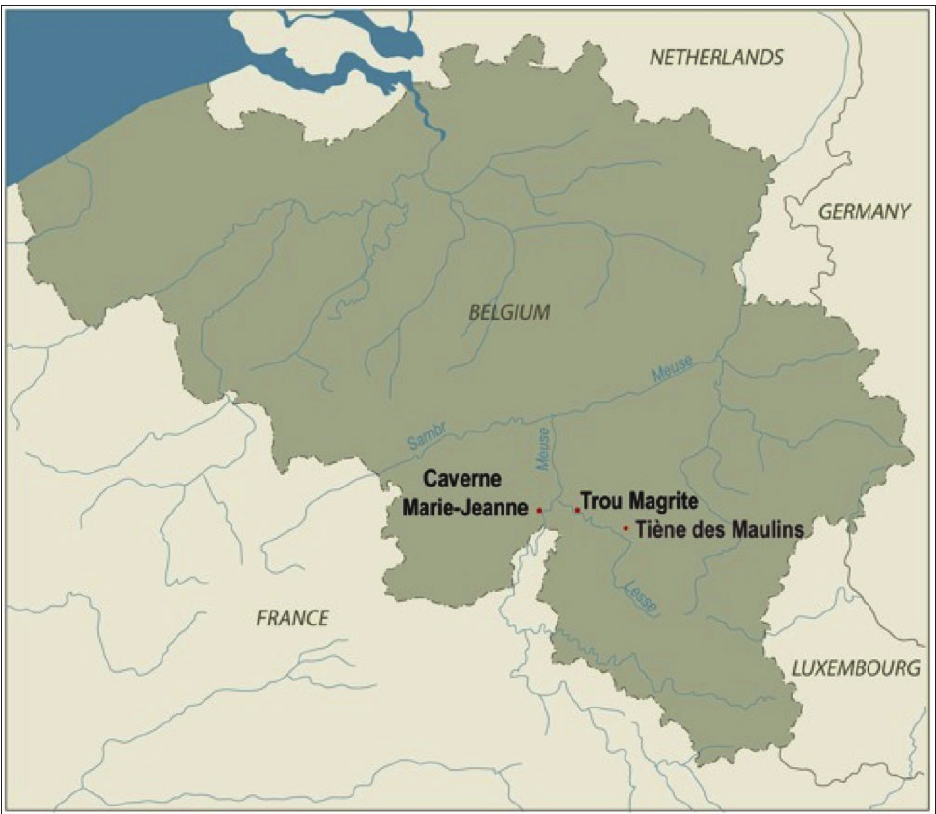
Figure 1: Localisation of the sites in Belgium. 1: Tiène des Maulins; 2: Trou Magrite; 3: Caverne Marie-Jeanne (map: N. Bloch,